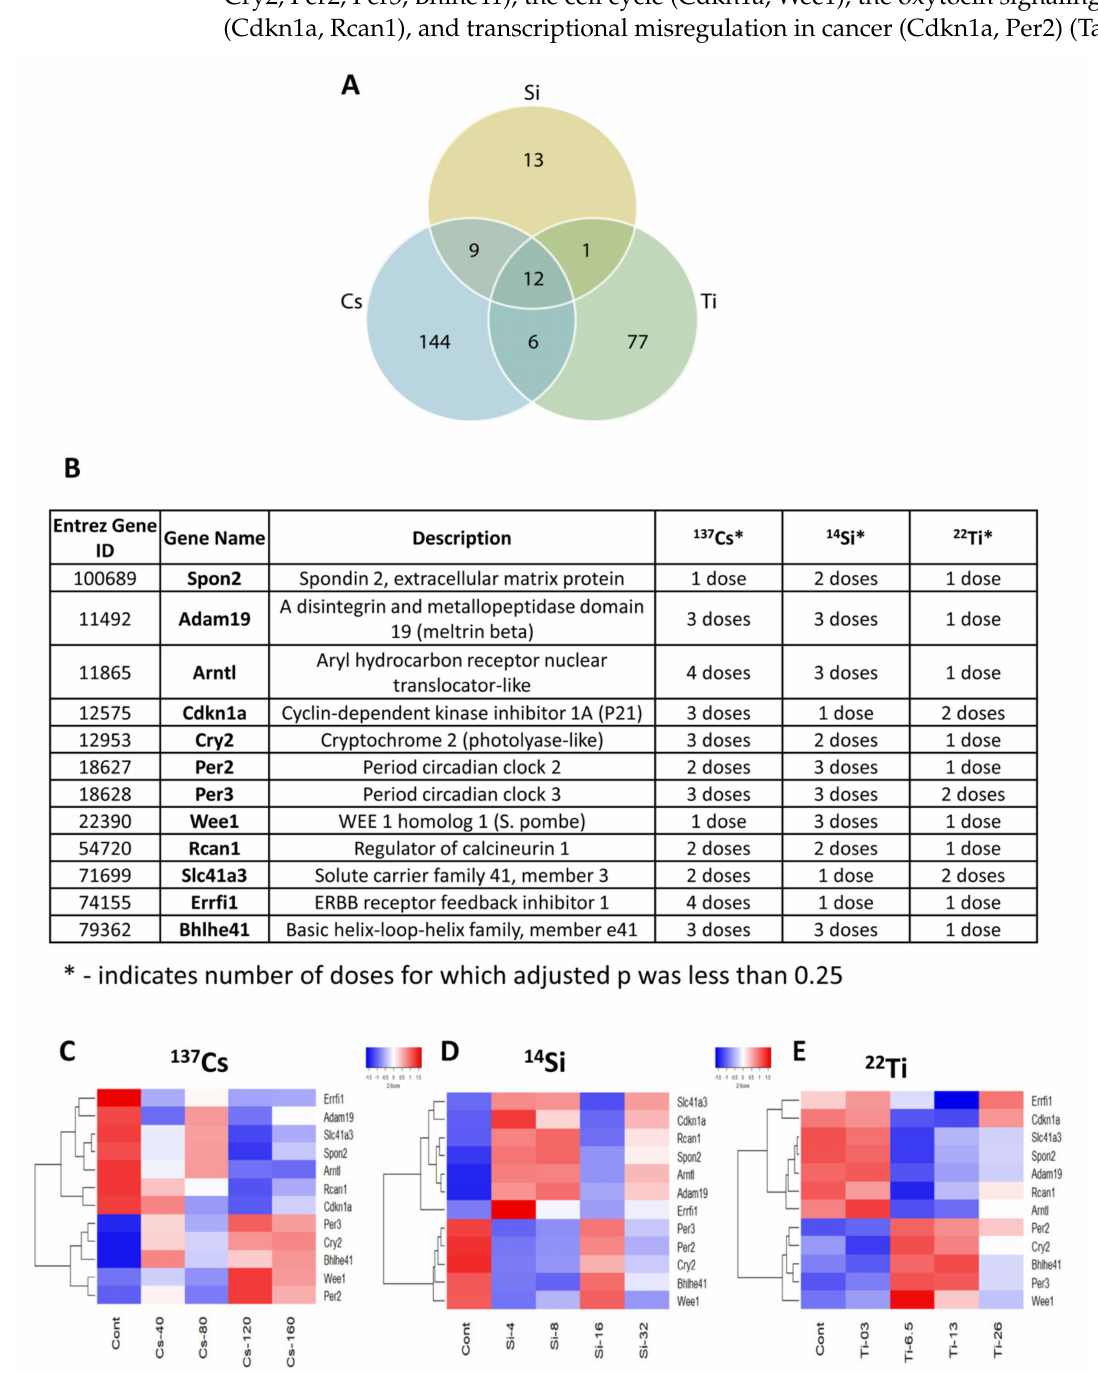
Figure 4. Overlapping differentially expressed genes: ( A ) Venn diagram depicting the overlap of enrichment terms amongst three different radiation exposure groups ( 137 Cs, 14 Si, and 22 Ti) compared to the control group. In the diagram, blue circles represent genes putatively affected by long-term 137 Cs exposure, yellow circles represent genes influenced by 14 Si exposure, and green circles represent those affected by 22 Ti exposure. ( B ) Table depicting 12 commonly expressed genes in one or more of all radiation-type exposures and ( C – E ) microarray data analysis showing heat maps of the 12 overlapping commonly expressed genes in different radiation groups/doses. Relative expression values are indicated on the color key and increase in value from blue to red ( n =